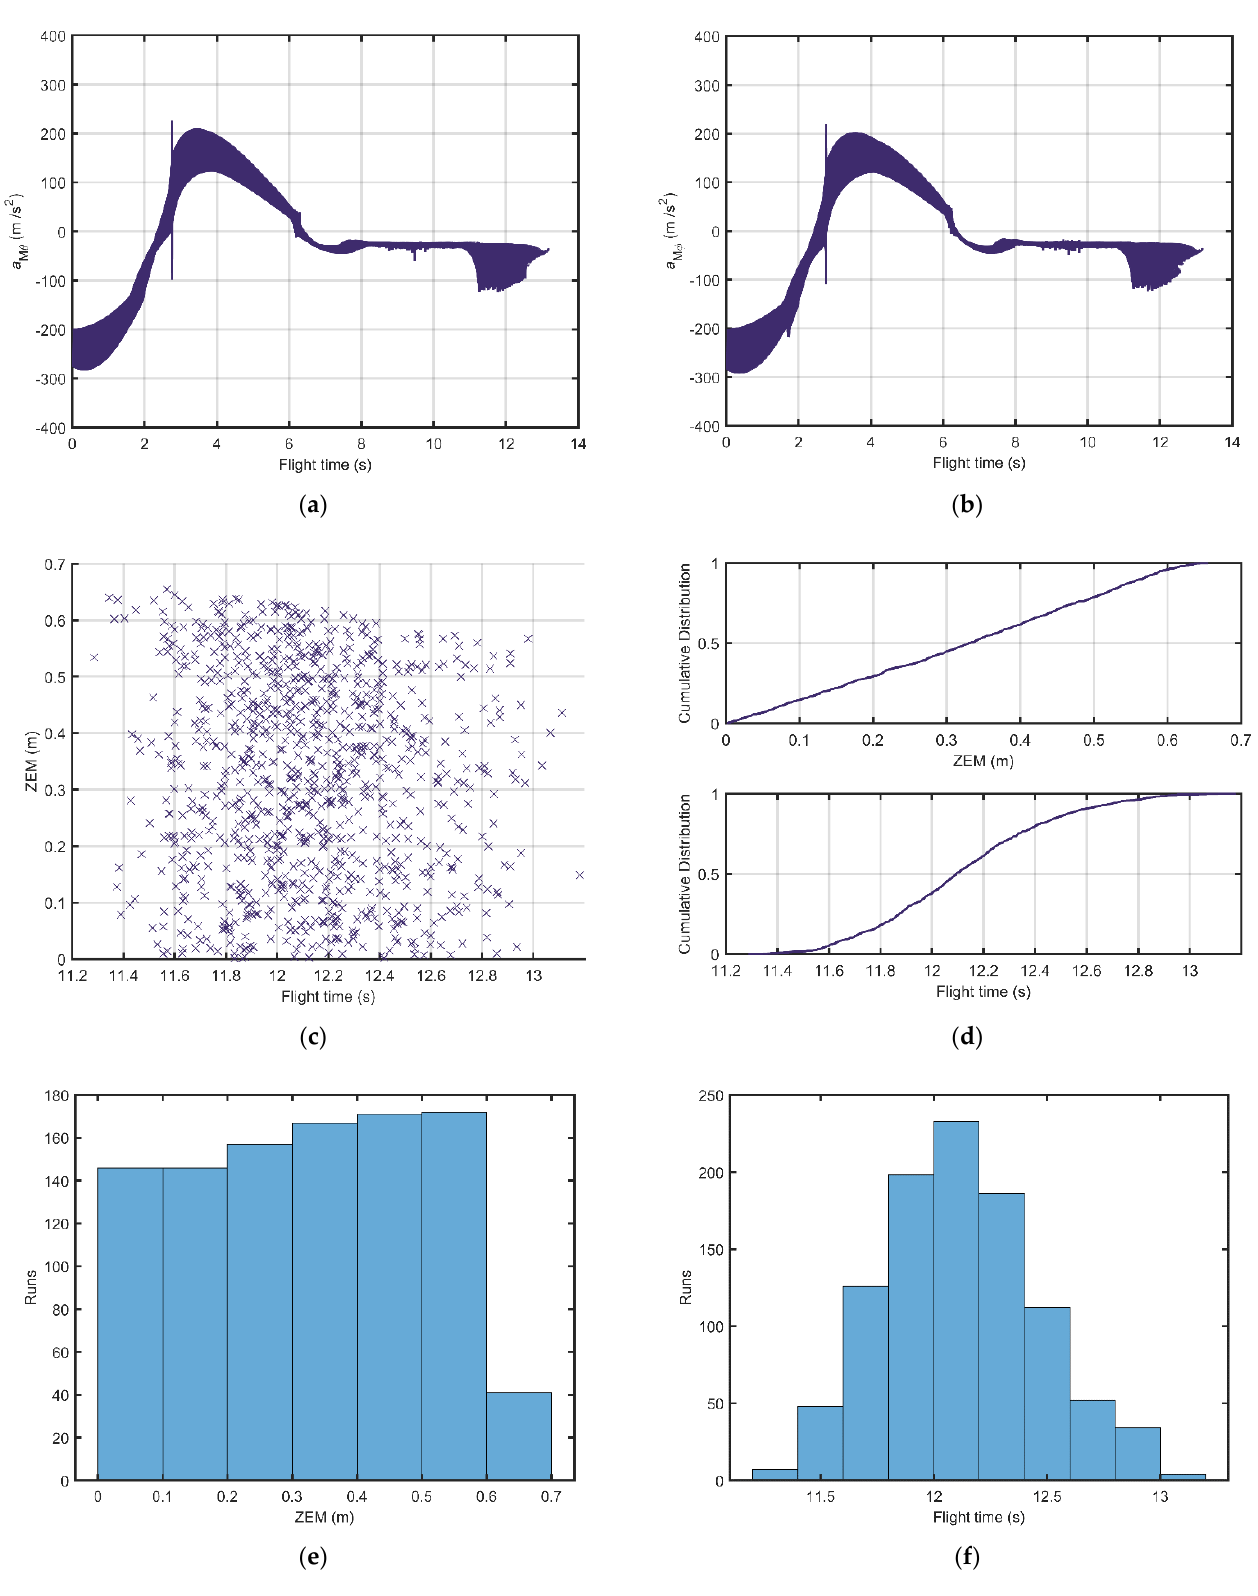
Figure 5. The Monte Carlo simulation results: ( a ) Missile accelerations along θ axis; ( b ) Missile accelerations along φ axis; ( c ) The flight time and ZEM of the 1000-run simulation; ( d ) The cumulative distribution function of ZEM and flight time; ( e ) The ZEM distribution in the 1000 runs; and ( f ) The Flight time distribution in the 1000 runs.